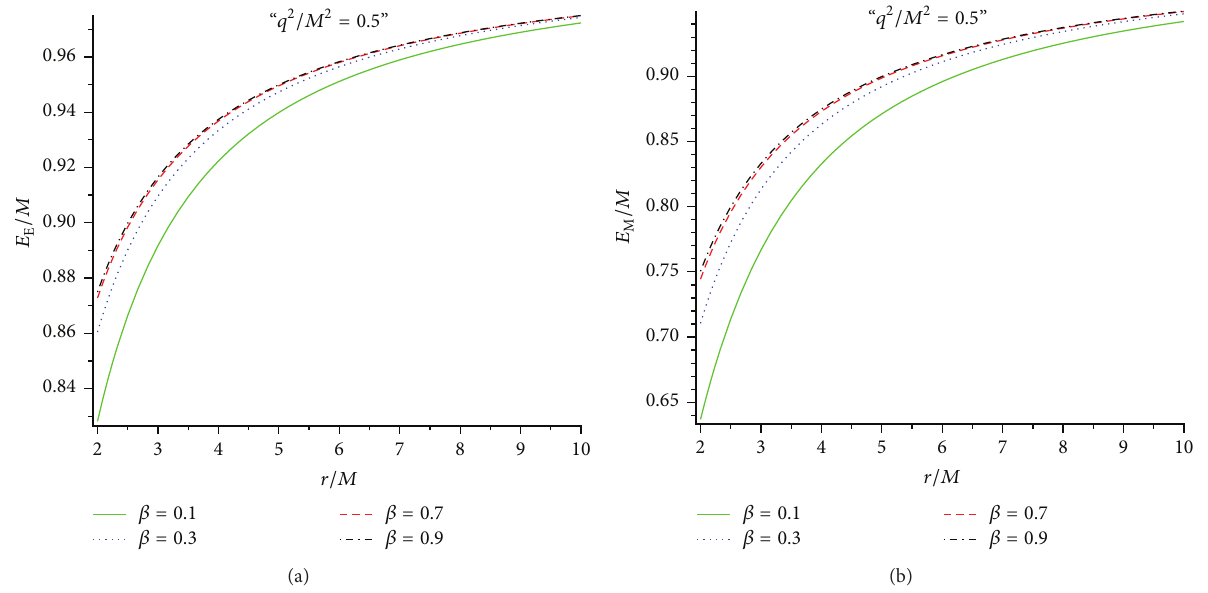
Figure 2: (a) Energy distribution computed by the Einstein prescription outside the outer horizon for four different values of 𝛽 . (b) Energy distribution computed by the Møller prescription outside the outer horizon for four different values of 𝛽